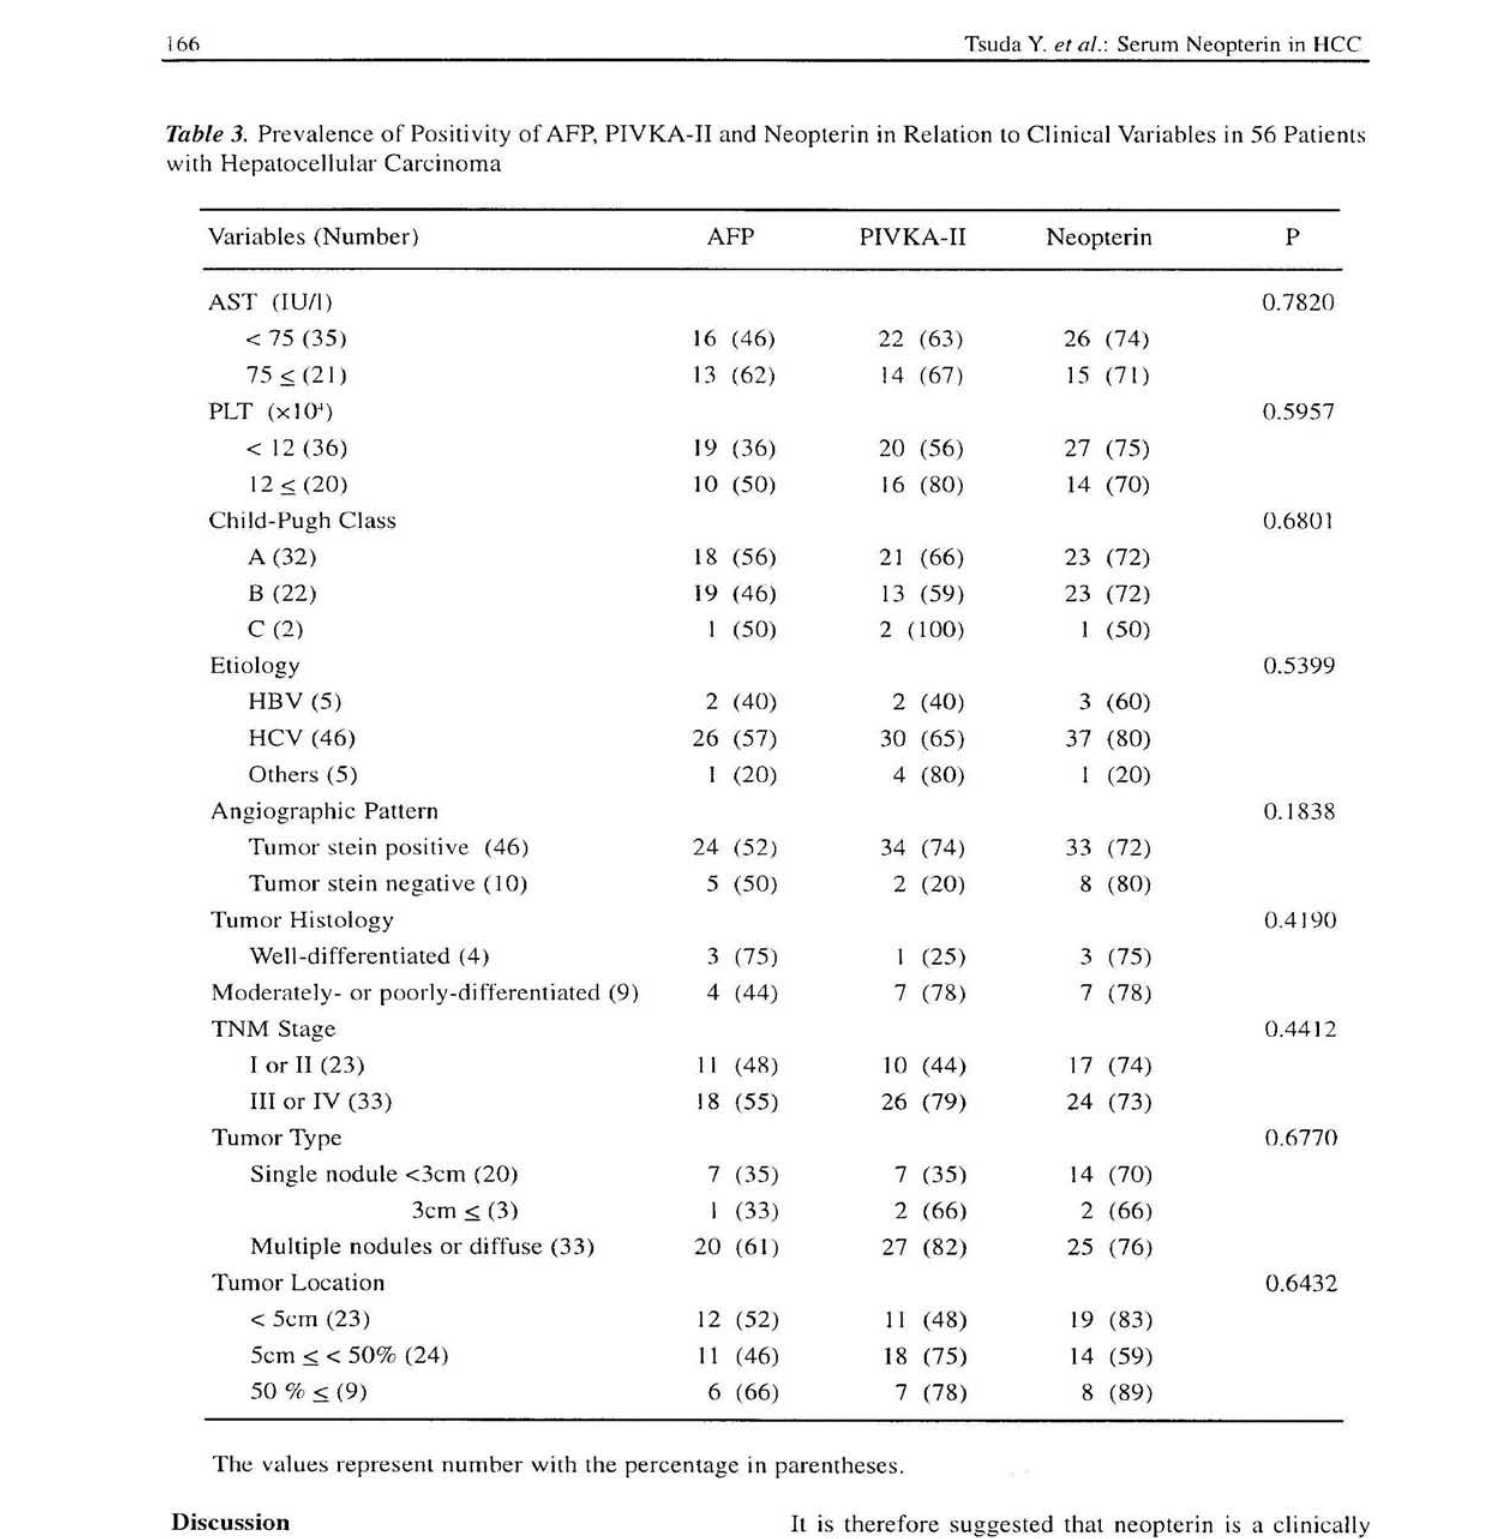
Table 3. Prevalence of Positivity of AFP, PIVKA-II and Neopterin in Relation to Clinical Variables in 56 Patients with Hepatocellular